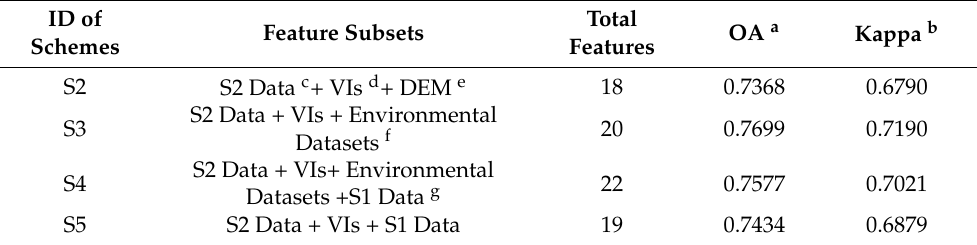
Table 5. Classification Results for Schemes S2–S5.